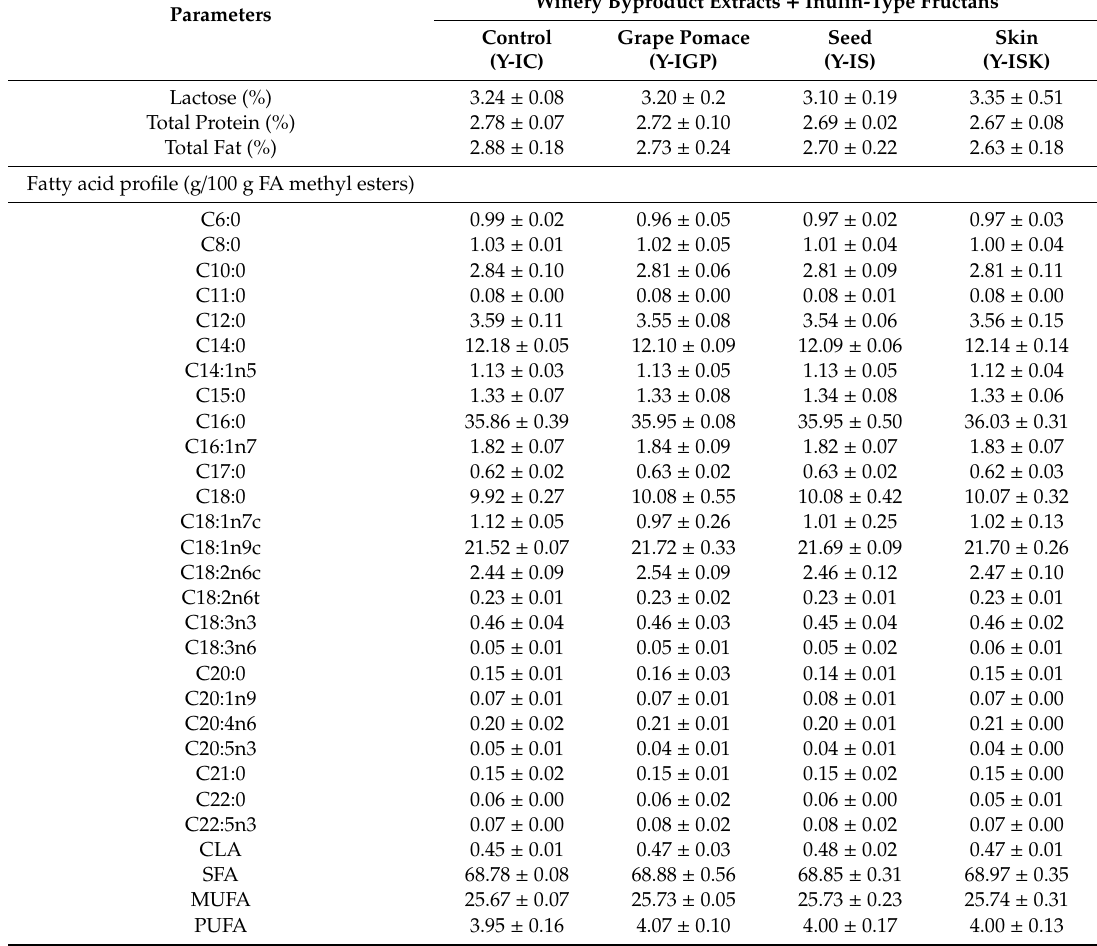
Table 3. Total lactose, protein, fat and fatty acid content (g / 100 g of FA methyl esters) of yogurts containing inulin-type fructans together with grape pomace, seed and skin extracts, at day one after yogurt